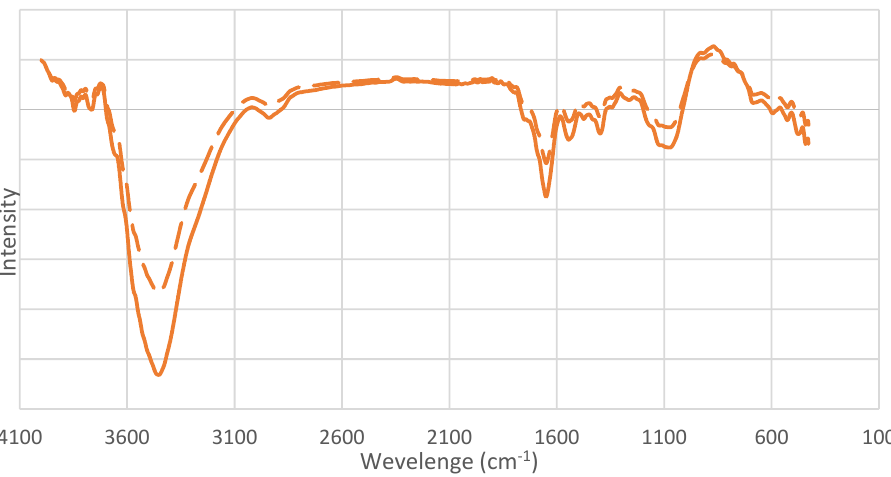
Figure 6. FT-IR spectra of non-pretreated (solid line) and biologically pretreated rice straw (dash line).